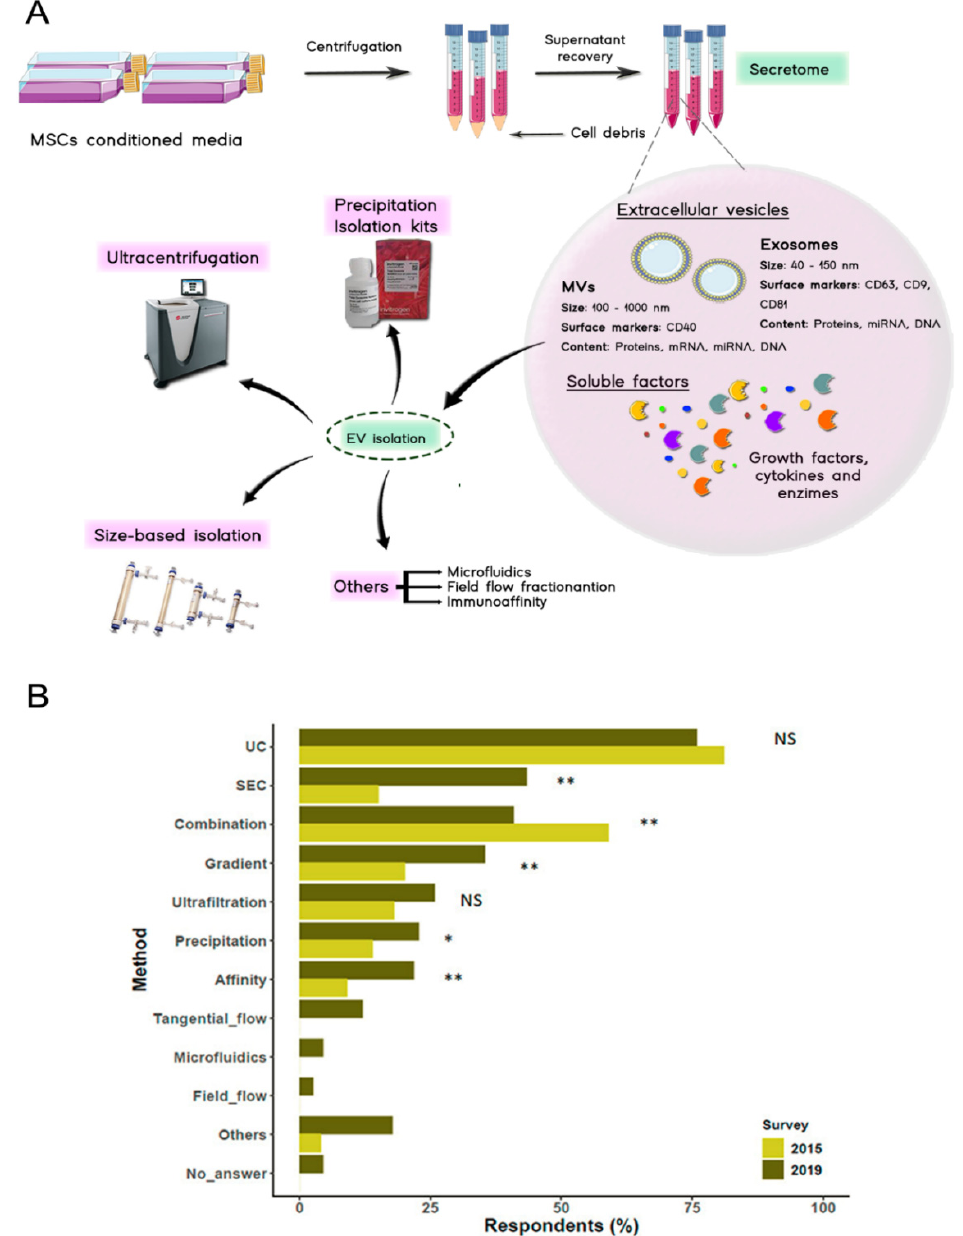
Figure 3. ( A ) Secretome isolation starts with a centrifugation stage where cell debris are pelleted and discarded, after that, secretome fractions can be isolated by employing different techniques such as centrifugation, size-based isolation techniques or commercial kits among others. ( B ) Results of the survey carried out by the ISCT regarding the techniques used for the isolation of EVs in 2019. Ultracentrifugation and a combination of size-based isolation techniques are the most commonly used protocols for EV isolation. (NS, non-significant, * p < 0.05, ** p < 0.01. Missing bars: not queried in the 2015 survey) (Adapted with permission from